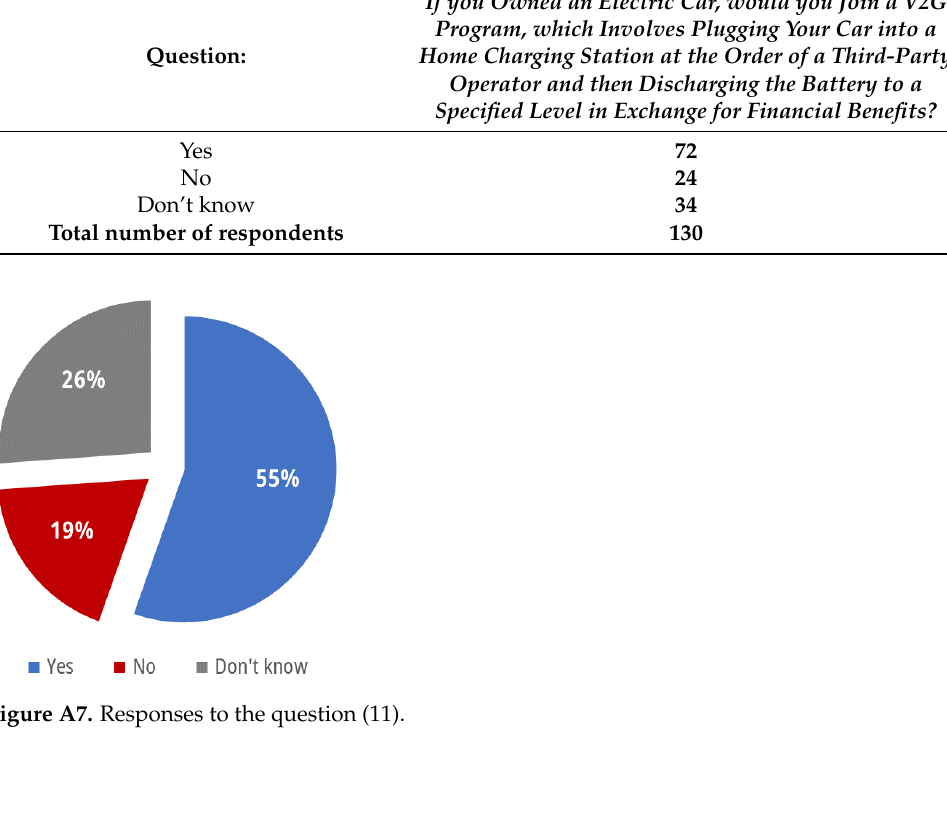
Figure A8. Responses to question (12). The responses to the questions presented in Table A8 address the situation where the provision of discharging services is similar in concept to V2H technology. Based on the survey results, it can be concluded that most respondents would be willing to discharge vehicles at their home. At this point, it is important to see how many of the respondents would make the decision to join the V2G Program in their own home without any knowledge of V2G technology, based only on the brief explanation provided in the survey. We found that of the 74 respondents who answered in question (10) that they had knowledge of V2G technology, as many as 49 of them would be willing to provide V2G services in the home. Of the 33 people who answered “No” in question (10), only 9 people would not be willing to provide EV discharging services at their home, 12 people do not